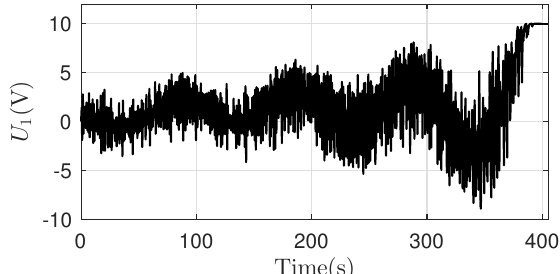
Figure 32. Control input U 1 in virtual mooring.